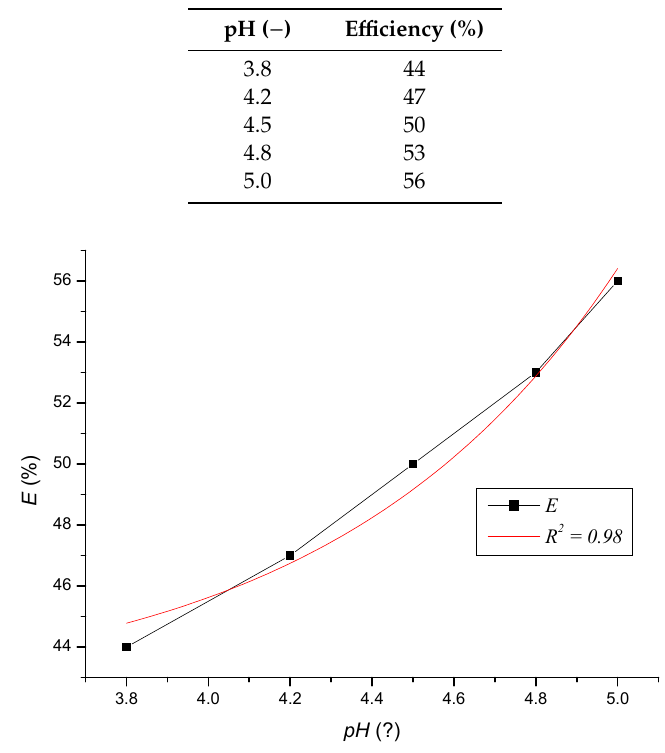
Table 5. E ffi ciency of clinoptilolite depending on the pH value of the wastewater.